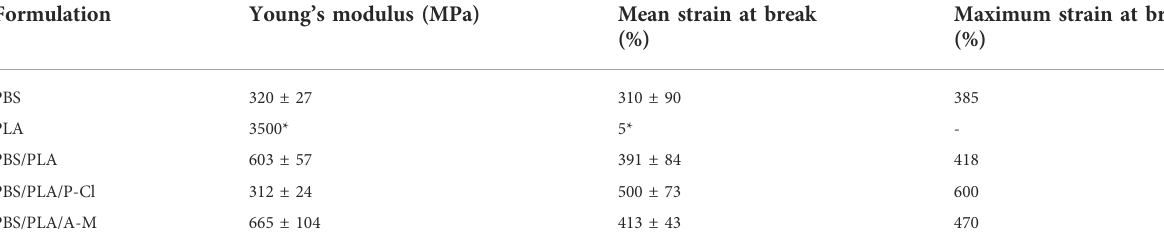
TABLE 2 Mechanical properties of neat PLA and PBS and PBS/PLA blends. *Data provided in product datasheet.